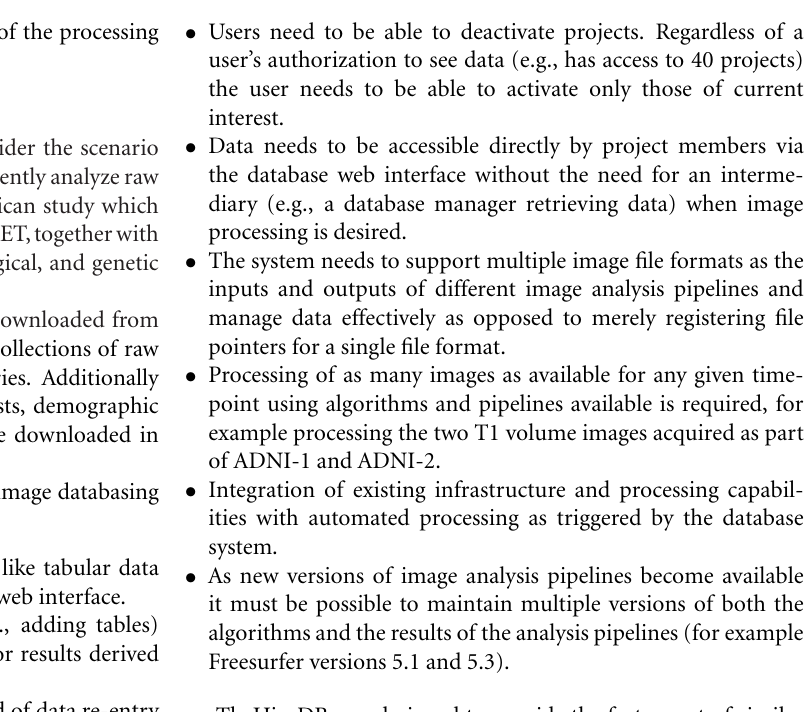
in combination. Additionally multiple versions of the processing algorithm can be used and results